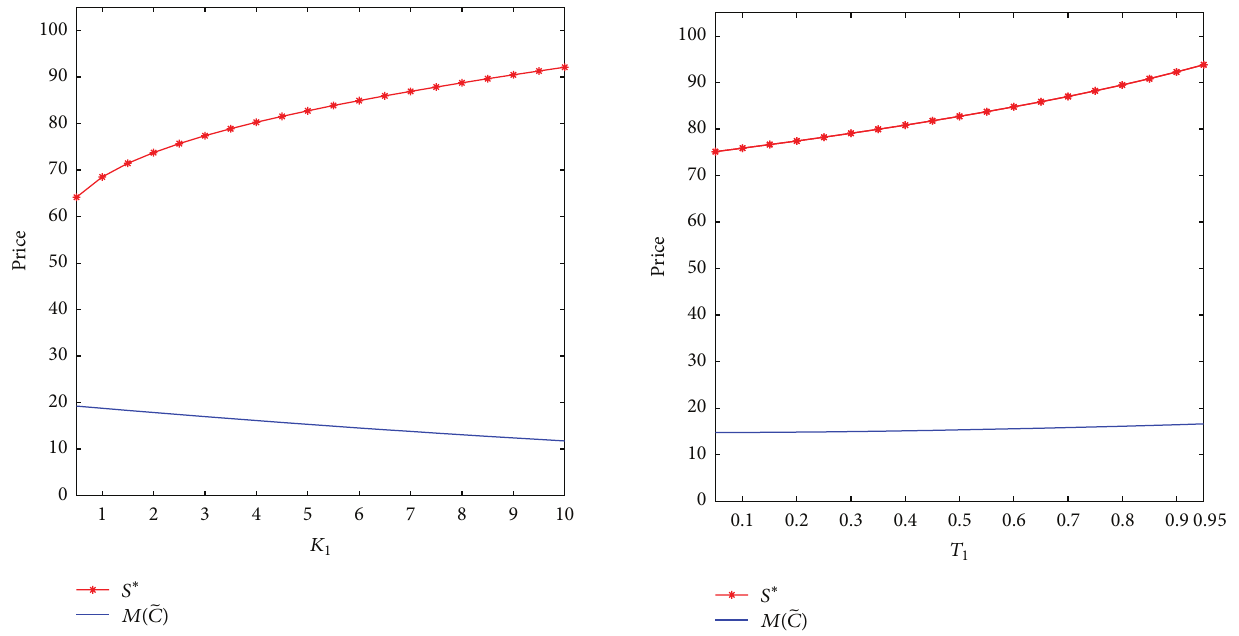
Figure 2: The sensitivity analysis of 𝑆 ∗ and